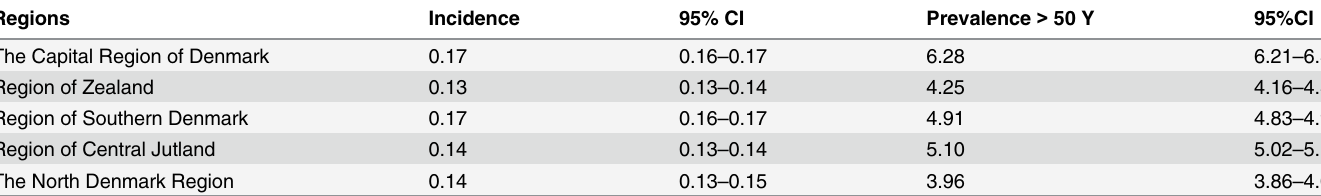
Table 3. The demographic variation of glaucoma in Denmark. The incidence and prevalence for 2011 is calculated.